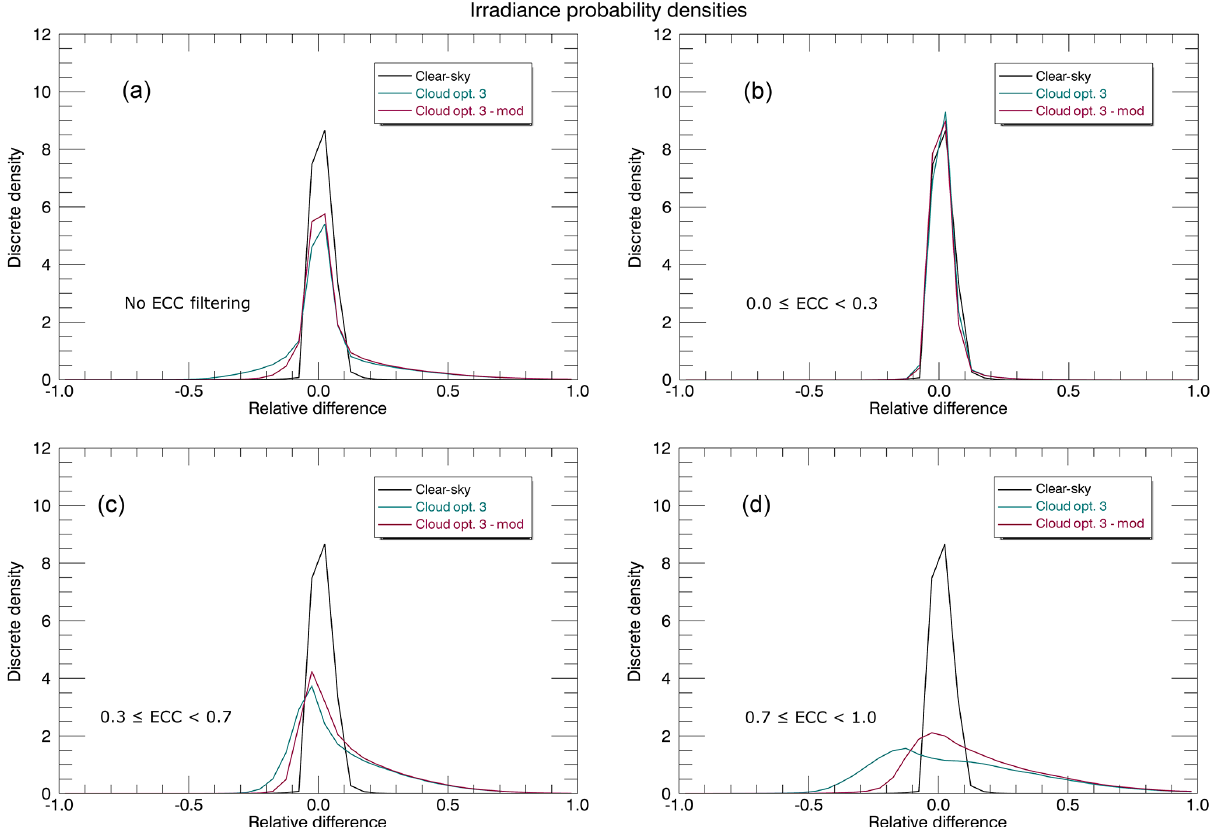
Figure 13. Irradiance probability density plots demonstrating the dependence of the 330–400nm surface irradiances on effective cloud cover (ECC). Plotted are the relative differences between the Cloud-J and GEM surface irradiances under unattenuated, clear-sky conditions (black), cloudy sky where the Cloud-J option 3 cloud flag is used to calculate cloud attenuation (green), and a modified version of the GEM model output for cloudy skies compared to the Cloud-J data employing the option 3 cloud flag (purple). The modification made to the GEM code was to change the effective radii for the ice clouds to determine if it made any difference relative to the Cloud-J output. In all four plots, a solar zenith angle filter was applied, in which only surface irradiances pertaining to locations where zenith angles < 70 ◦ are used. A secondary filter for varying total effective cloud cover is employed in the plots to display the relative difference in irradiances for a given range of cloud cover from clear sky (0.0) to completely overcast